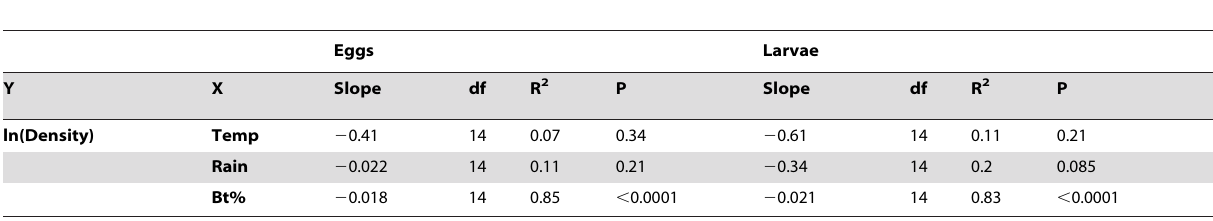
Table 2. Stepwise regression testing association of Bt cotton (%), temperature, and rainfall with population density of pink